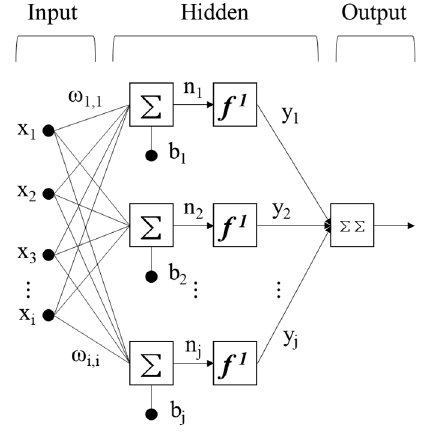
Figure 5. Procedure of an artificial neural network from an input sample.